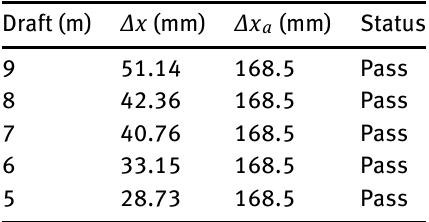
Table 8: Deformation test results and status on draft